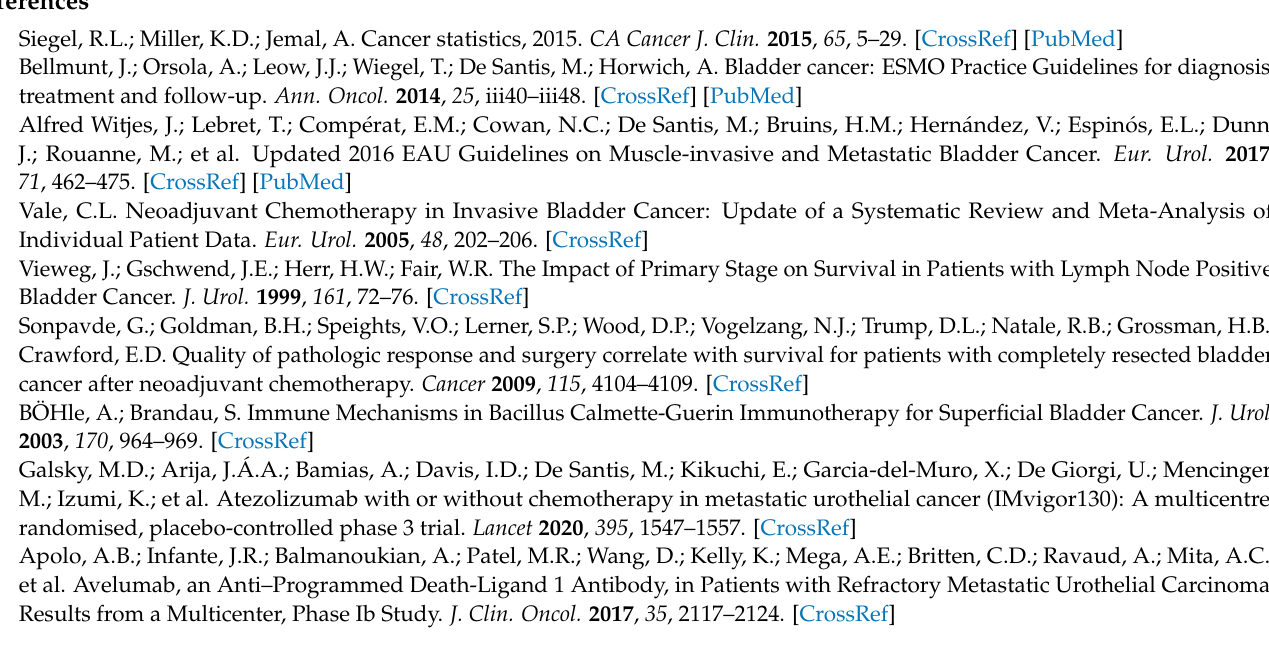
outcome. Figure S4—Pathology slides for the Immunoscore determination. Table S1—Bivariable analysis for clinical parameters for OS. Table S2—Multivariable analysis immune score vs clinical parameters for TTR and